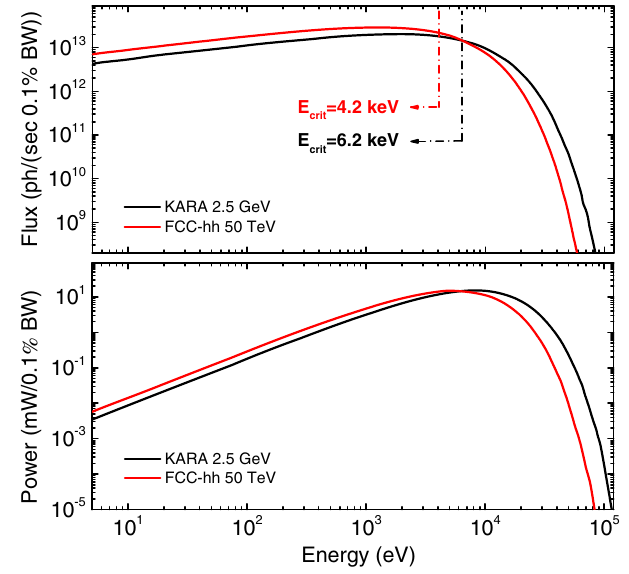
FIG. 1. Comparison of the photon flux (a) and power (b) of the FCC-hh at 50 TeV proton beam energy in comparison with KARA ’ s at its nominal 2.5 GeV. Calculations were performed with S YNRAD +